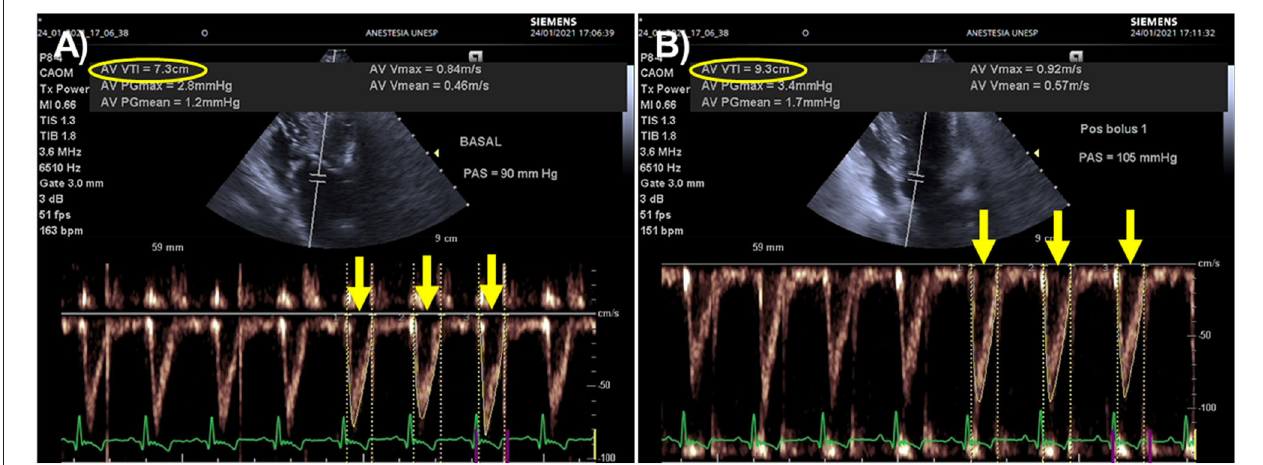
FIGURE 4 | Effects of a fluid challenge with 10 ml/kg of lactated Ringer’s solution administered over 5min on aortic flow velocity time integral (VTI) recorded from an apical five-changer view in a dog with blunt trauma. An automated algorithm was used to measure aortic flow VTI as the average of 3 sequential heartbeats (yellow arrows). (A) Heart rate (HR), Doppler systolic arterial pressure (SAP), and aortic flow VTI before the fluid challenge were 163 beats/min, 90 mmHg and 7.3cm (yellow oval), respectively. (B) After the fluid challenge, HR, Doppler SAP and aortic flow VTI were 151 beats/min, 105 mmHg and 9.3cm (yellow oval). This animal was a responder to volume expansion because aortic flow VTI increased 27% (from 7.3 to 9.3cm). The minute distance (HR times VTI), a surrogate index used to track changes in cardiac output, increased 17% after the fluid challenge (from 1197 to